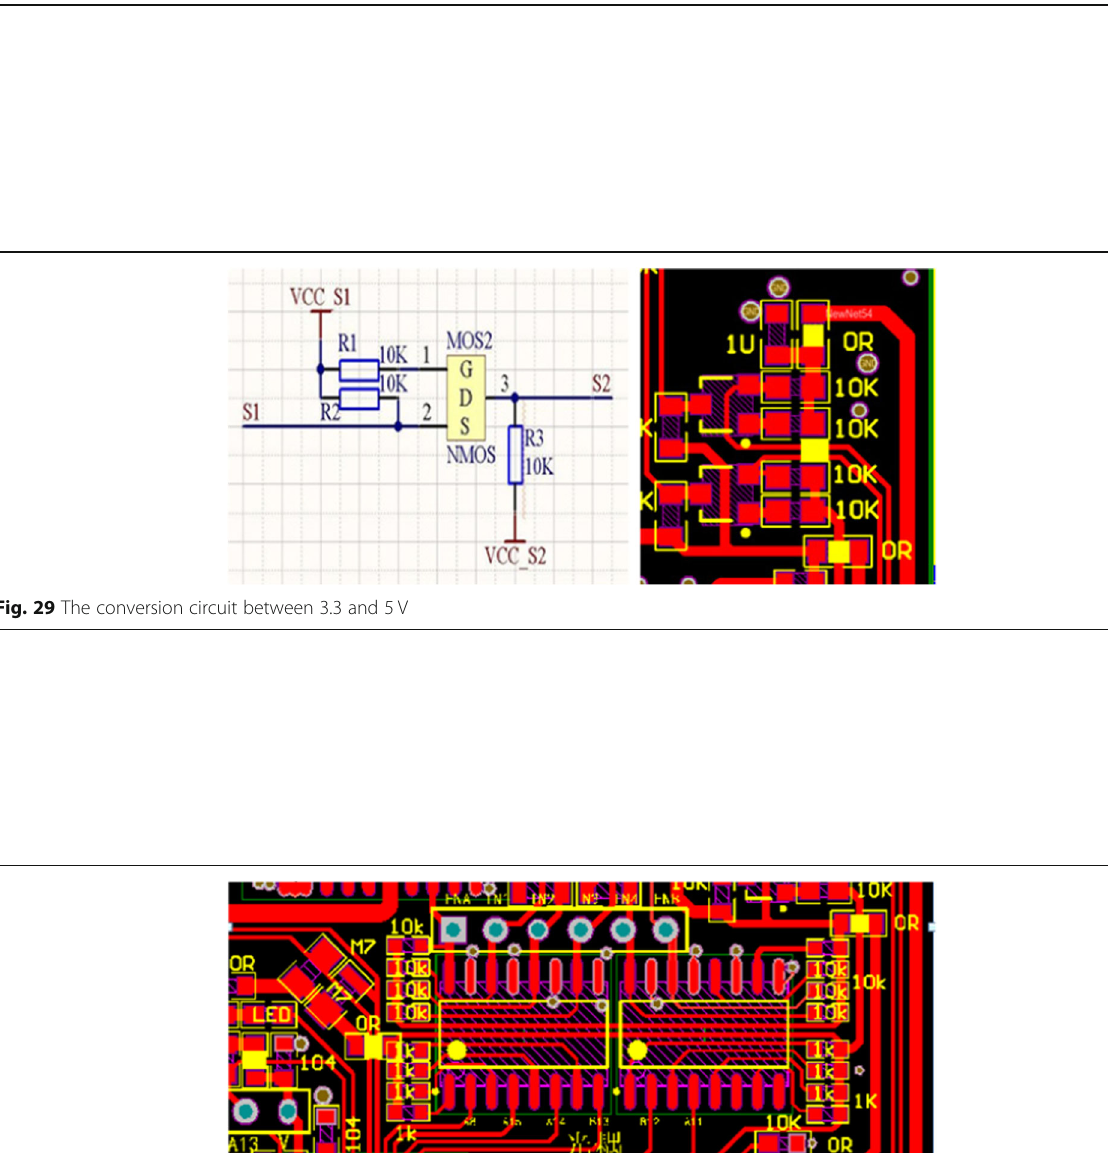
Fig. 28 Bluetooth module interface circuit and joint diagram